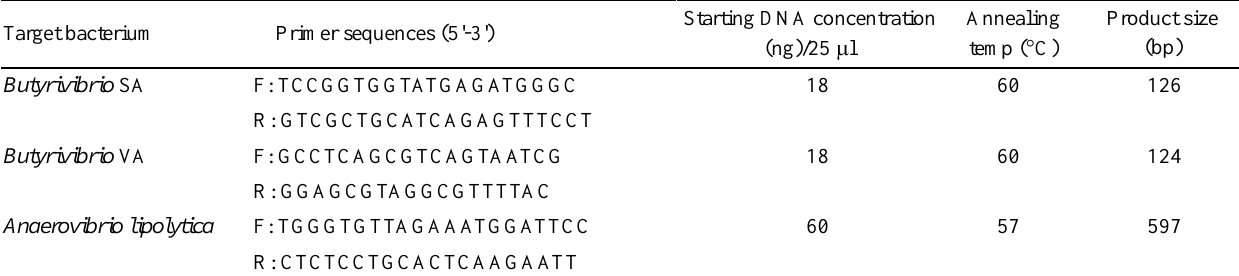
Table 2. PCR primers and starting DNA concentration for detection of selected ruminal bacteria Target